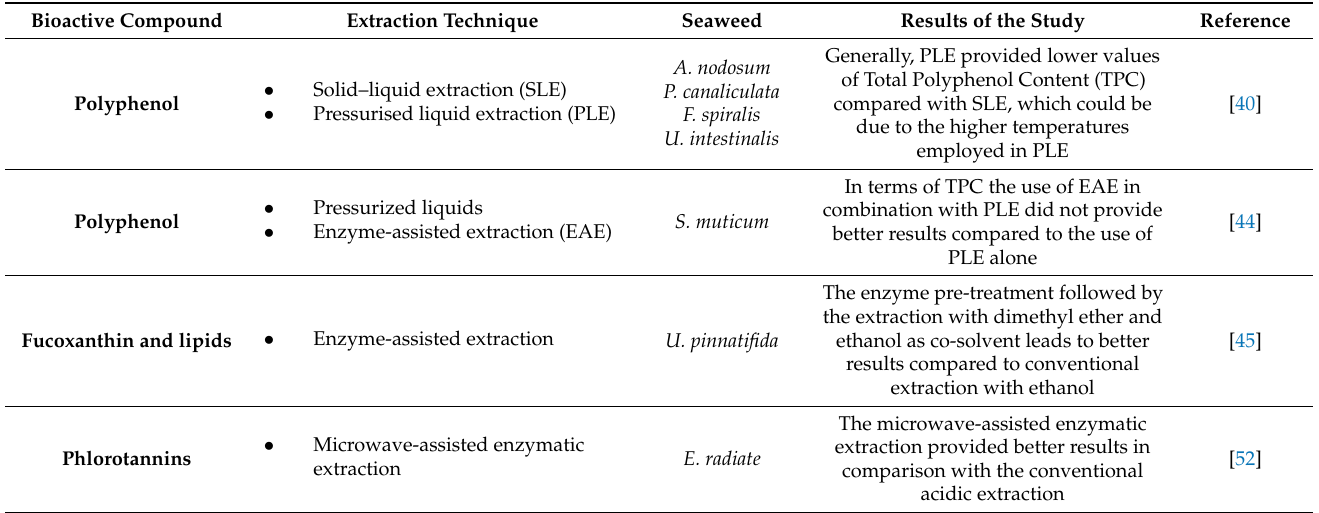
Table 2. Overview of the main extraction methodologies for bioactive compounds of seaweeds. Bioactive